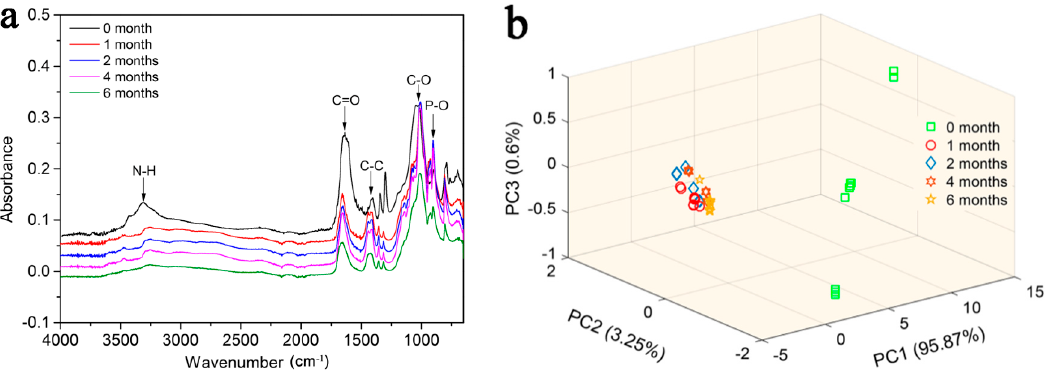
Figure 2. Average ATR-FTIR spectra of MOF and the principal component analysis (PCA) distributions based on the ATR-FTIR of the MOF with different treatments. ( a ). Spectra of MOF degraded in wheat farm soil for zero months, one month, two months, four months, and six months. ( b ). The first three PCA scatterplots based on the ATR-FTIR spectra of MOF.